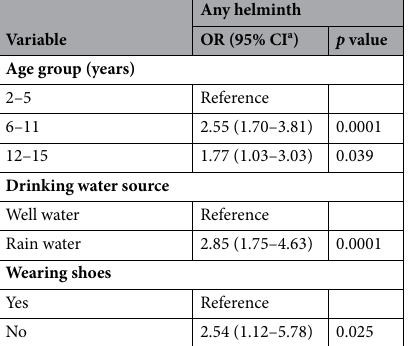
Table 7. Multivariable logistic regression analysis of risk factors related to helminth infections in R.A.A.N. (Nicaragua). Factors identified as statistically significant at the 5% level in univariable analysis were entered into a stepwise forward logistic regression model. a 95% confidence